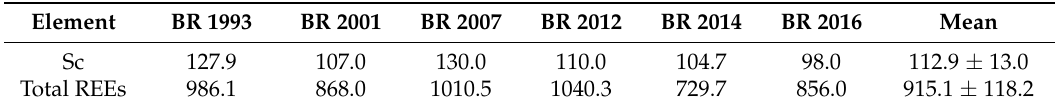
Table 1. Concentration [g/t] of Sc and rare earths elements (REEs) in Greek bauxite residue (BR) batches